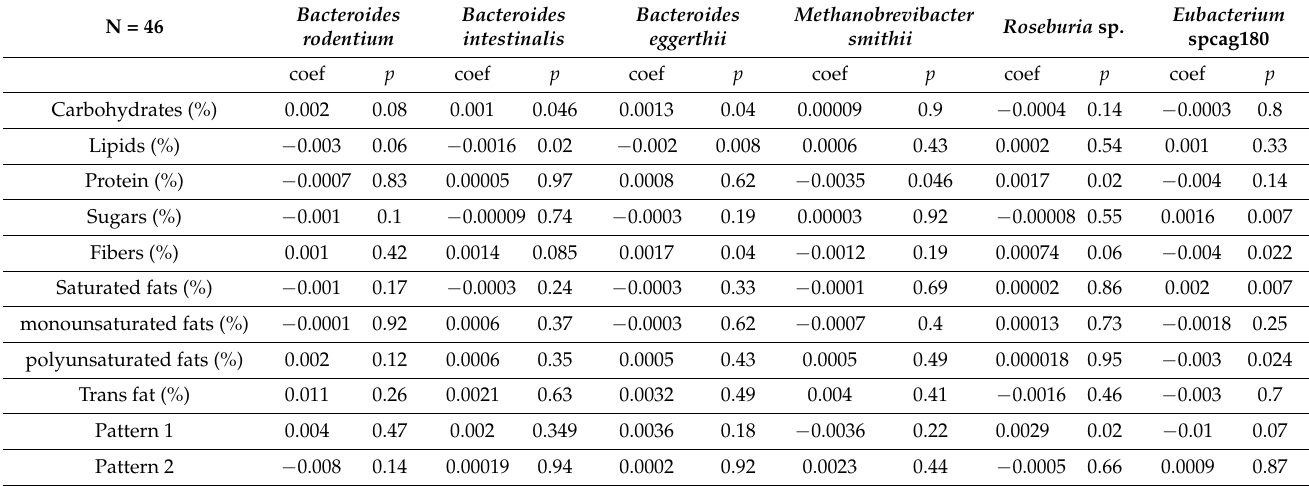
Table 2. Association analysis between taxa and macronutrient percentage intake.